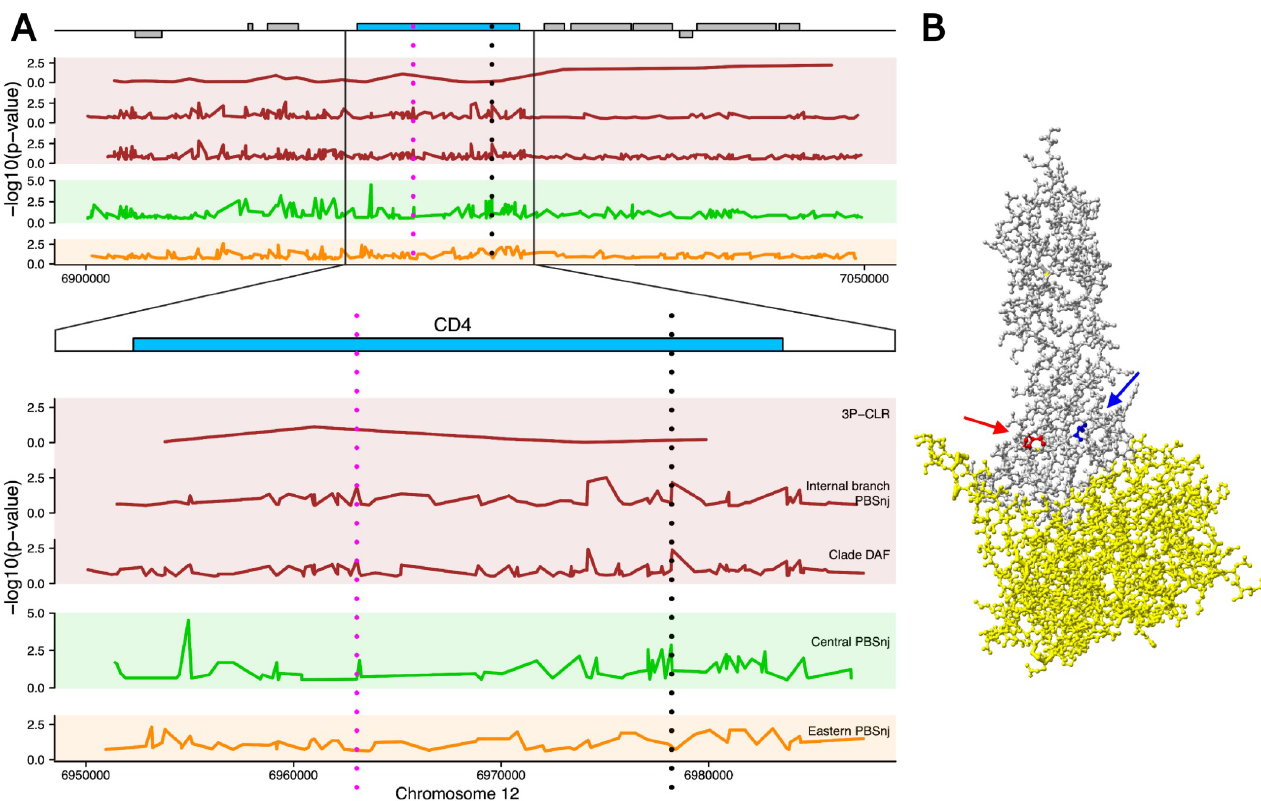
Fig 4. Signatures of selective sweeps in the extended CD4 locus. A. Genomic representation of 150 kb and a magnified view of CD4 with signatures of positive selection from 3P-CLR, PBSnj and clade-DAF. Statistics are coloured by population. The vertical dotted lines indicate best candidate SNPs of interest. The pink line indicates a splice site synonymous variant at position 6963043 with signatures of positive selection in the central-eastern ancestor. The black dotted line indicates two SNPs 39bp apart: a missense SNP in position 6978193 (the V55I SNP) with signatures of positive selection in centrals, and a missense SNP at position 6978232 (the P68T SNP) with signatures of selection in the central-eastern ancestor. For the DAF of these candidate SNPs across chimpanzee subspecies see Fig E in S1 Appendix. B. Protein structure diagram showing the first two CD4 domains (grey) bound to the HIV envelope protein (yellow) [50] and the amino acids corresponding to the two missense SNPs of interest, 6978193 (V55I) in blue and 6978232 (P68T) in